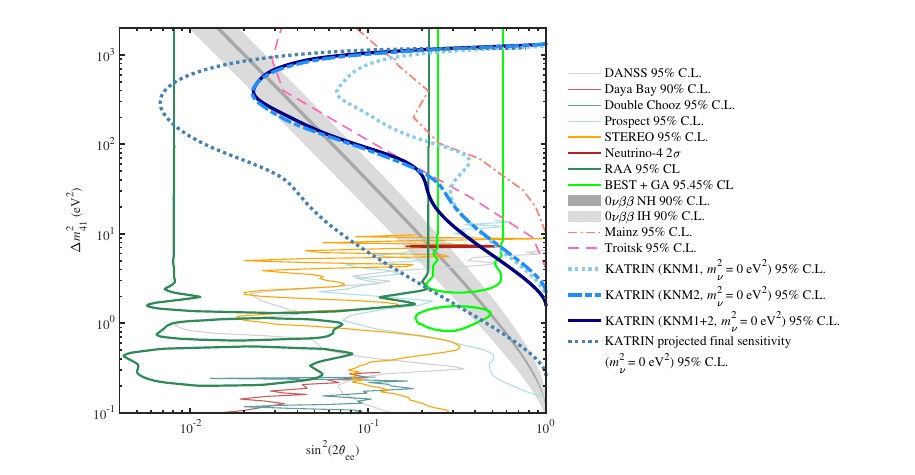
Figure 4. eV-scale sterile neutrino exclusion contours at 95% C.L. for the first and second campaign of KATRIN [16]. The combined results of the two campaigns as well the projected final sensitivity are also shown. These exclusions are compared to the most recent results from reactor, gallium, beta decay and double beta decay experiments. References for the di ff erent experimental results used in this plot can be found in